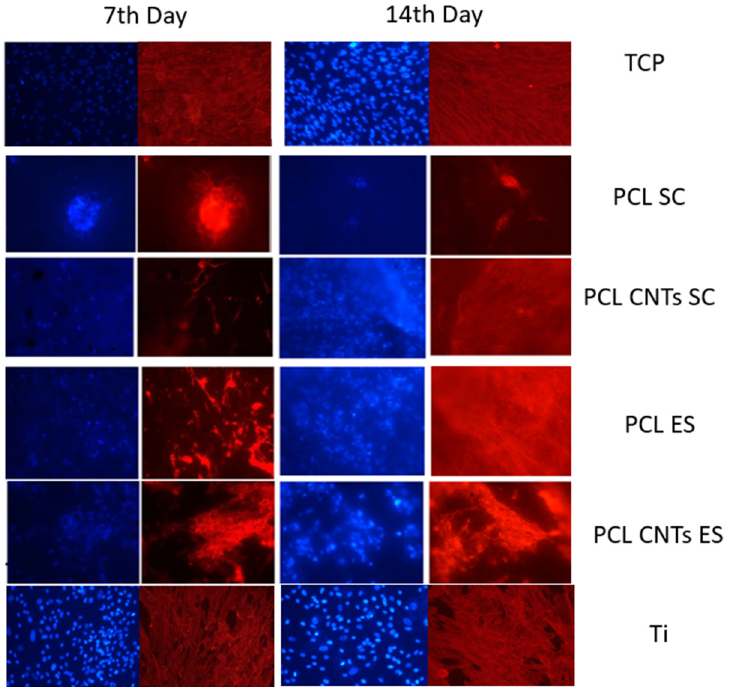
Figure 11. The 7th and the14th day of culture: Cells’ nucleus (stained with DAPI (blue)) and Cytoskeleton Actin (stained with phalloidin (red)) on PCL solvent cast, PCL-CNTs solvent cast, PCL electrospun, P-CNTs electrospun, and titanium, respectively (magnification 10×). Wang’s group observed reduced cell spreading on relatively stiffer substrates